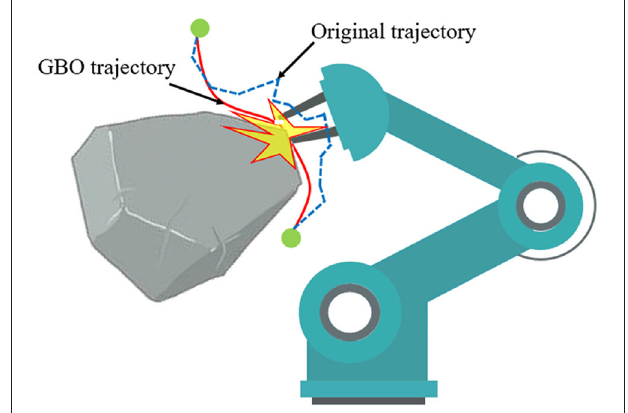
FIGURE 1 | When GBO falls into local optimal, the collision-free state of trajectory may be broken. Because the weighted cost function may cause GBO to ignore obstacles term f obs ( ξ ) at the local optimal point. The blue dotted line is the original trajectory produced by SBMPs, which is collision-free, while the red line is the optimized trajectory processed by